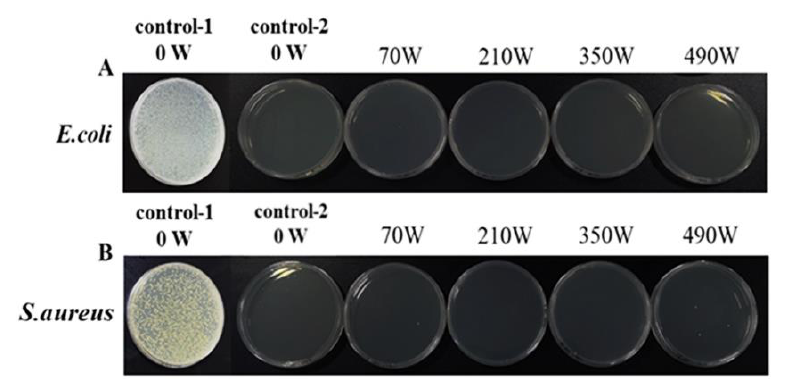
Figure 7. Effect of microwave power on the antibacterial activity of the lysozyme-oregano essential oil (LZ-OEO) bacteriostatic gels: ( A ) Escherichia coli ( E. coli ) and ( B ) Staphylococcus aureus ( S. aureus ). (Control-1 group was the gel system without bacteriostatic agent and control-2 group was the LZ-OEO bacteriostatic gel system without microwave treatment.)